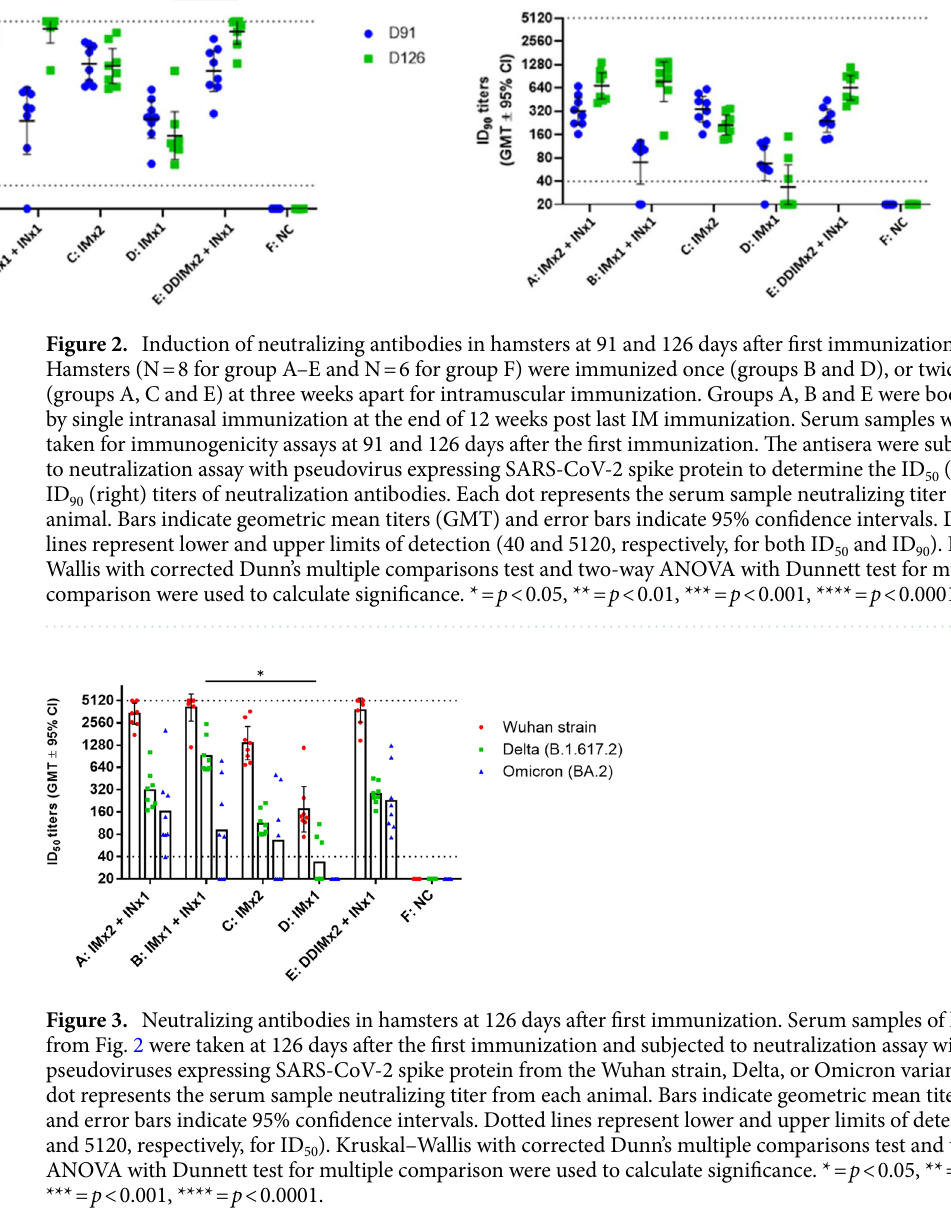
enough even in the IMx1 animal group that achieved significantly lower antibody titers than all other vaccinated groups (compare Figs. 2 and 4, Group D).